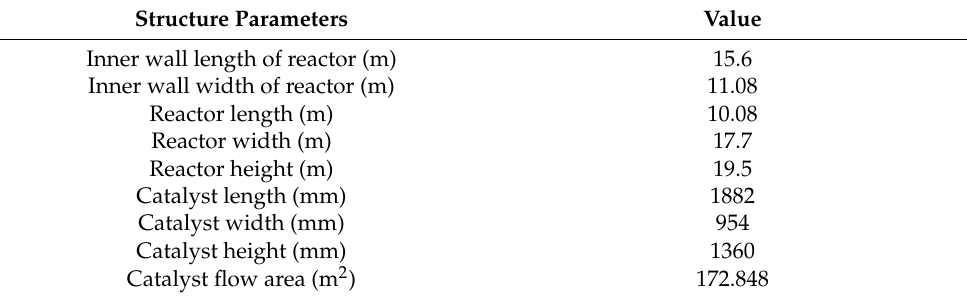
Table 1. Main structure parameters of the SCR denitration system Structure